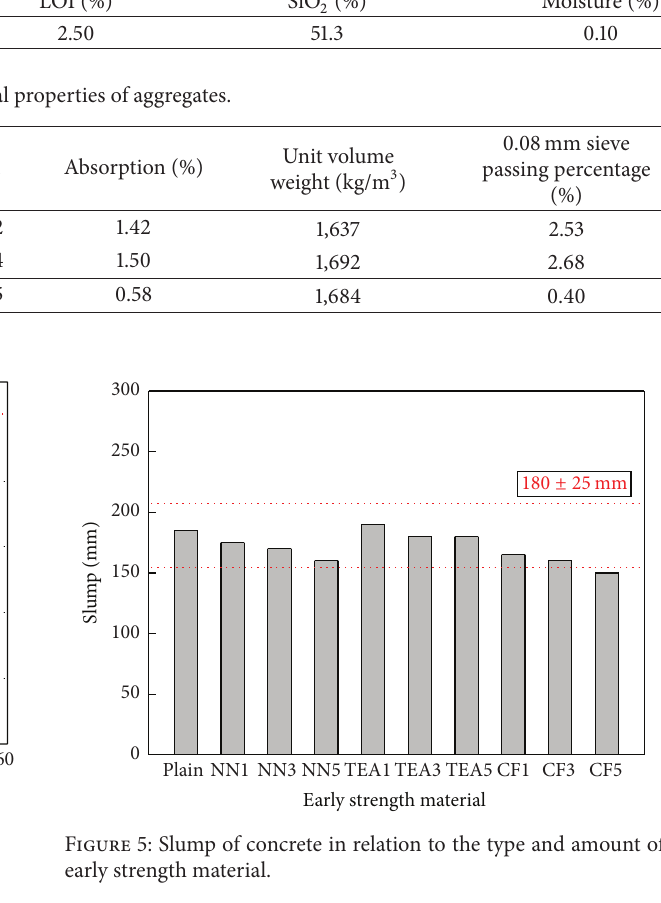
Figure 4: Drying shrinkage length change by age for various shrinkage reducing materials.